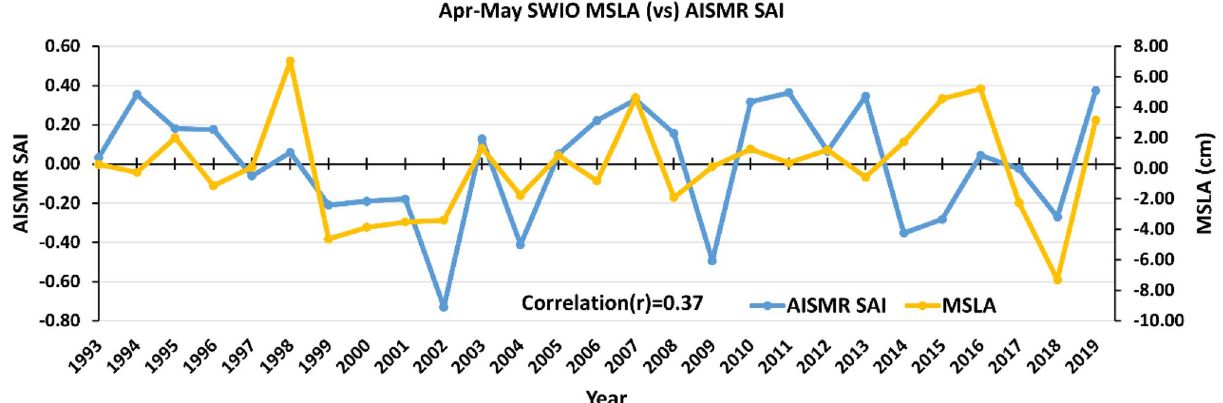
Figure 11. Time series of detrended Apr–May mean MSLA (yellow) over SWIO compared with detrended AISMR SAI (blue). The figure is generated using Microsoft